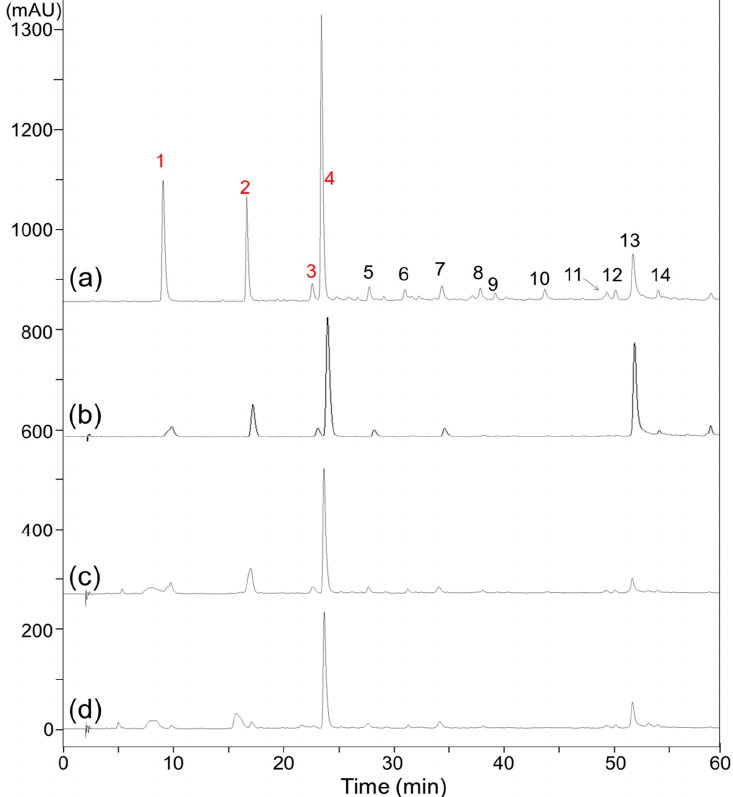
Figure 1. HPLC chromatograms of ethyl acetate fraction of 50% ( v / v ) methanol extract of evening primrose seed (EME) (a) and supernatant of EME buffer solution (ESME) (b), and ultrafiltration- HPLC chromatograms of EME incubated without human recombinant aldose reductase (c) and with human recombinant aldose reductase (d).